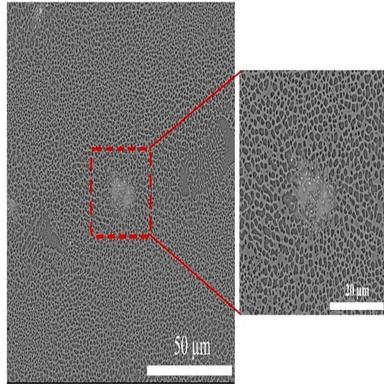
The fully decomposed MC carbide due to the high-temperature operation in the interdendritic area.